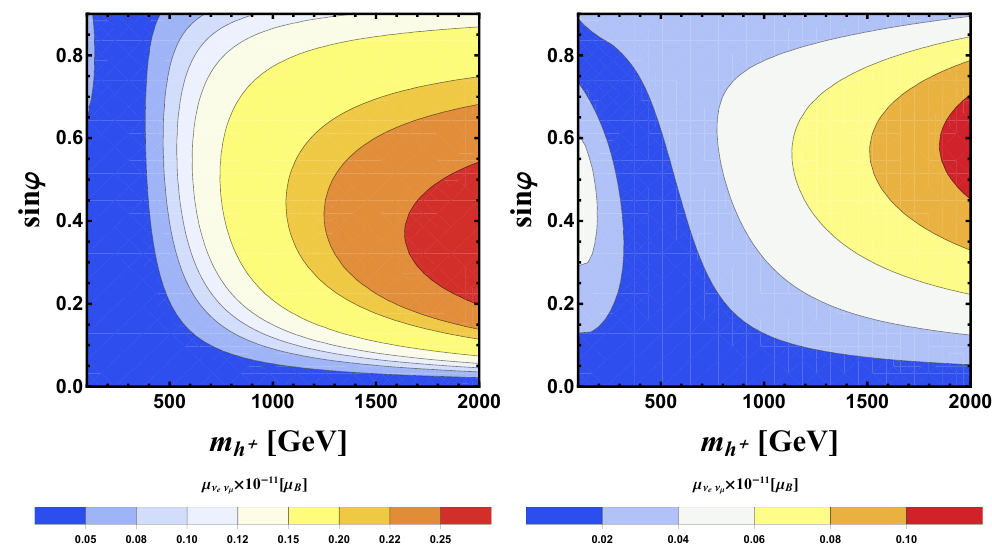
Figure 18 . Prediction of neutrino magnetic moment in m + Left panel: contribution from the top-bottom loop; right panel: through Higgs cubic and quar- tic